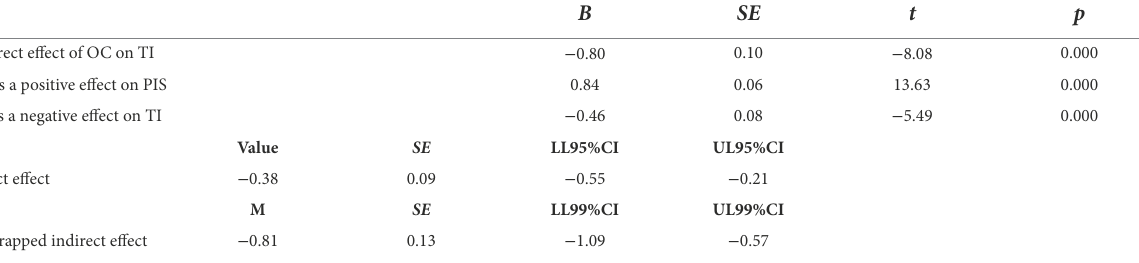
TABLE 3 Regression analysis results of the mediating